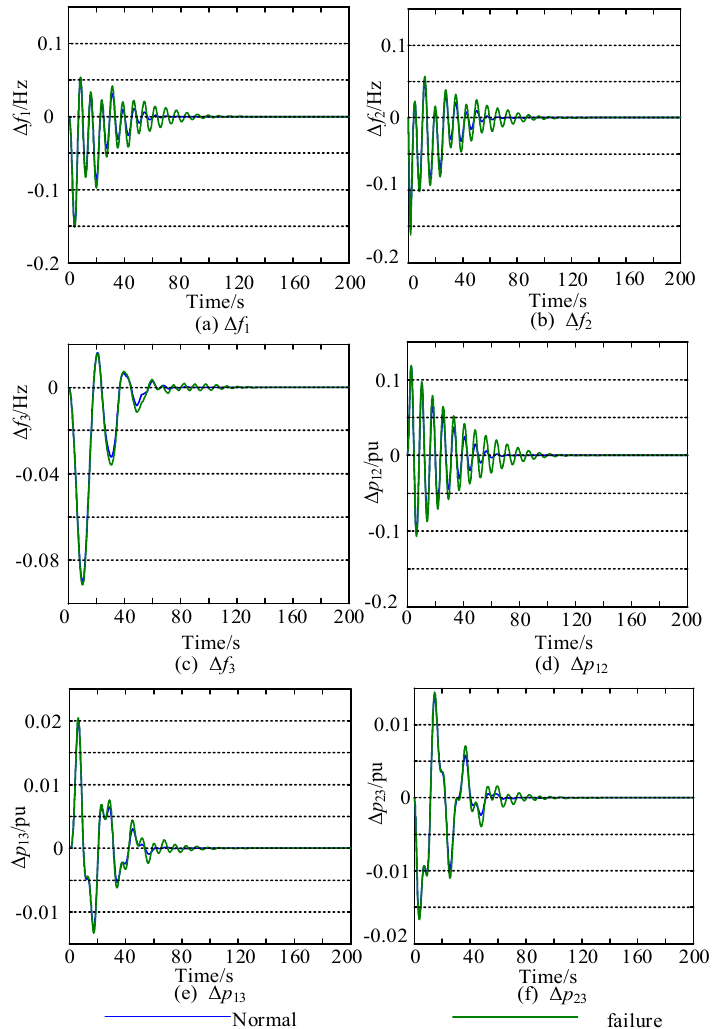
Figure 6. Results contrast curve under generator failure: ( a ) frequency deviation of the first CA; ( b ) frequency deviation of the second CA; ( c ) frequency deviation of the third CA; ( d ) tie-line power deviation between the first and second CAs; ( e ) tie-line power deviation between the first and third CAs; ( f ) tie-line power deviation between the second and third CAs.